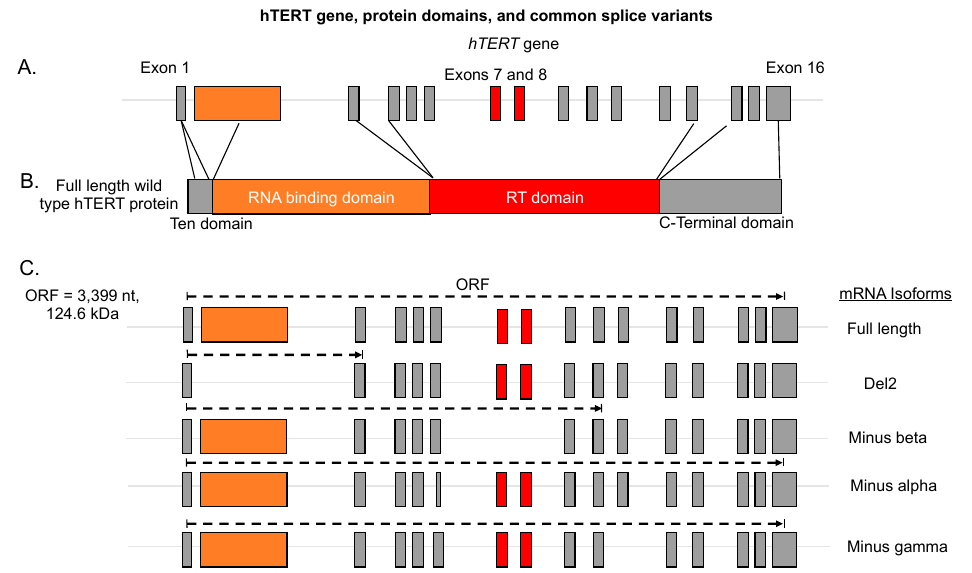
Figure 3. hTERT gene, protein domains and commonly studied splice variants. ( A ) Cartoon image of hTERT exons and introns. hTERT is a 16 exon / 15 intron gene that generates the reverse transcriptase component of the telomerase enzyme. Exon 2 is highlighted in orange as it is the major contributor to the telomerase RNA binding domain (TRBD). Exons 7 and 8 are highlighted in red as these two exons represent one of the most commonly studied splicing events in the hTERT gene and they encode for critical residues in the reverse transcriptase domain (RT). ( B ) Protein domains of hTERT. Lines linking exons to the domains they encode are shown. Critical domains are the TEN (exon 1), RNA binding (exons 2 and 3), RT (exons 4–13), and c-terminal (exons 14–16). All four of these domains are essential for telomerase activity, processivity, recruitment, and function. ( C ) Open reading frames of abundant hTERT alternative RNA splicing isoforms.